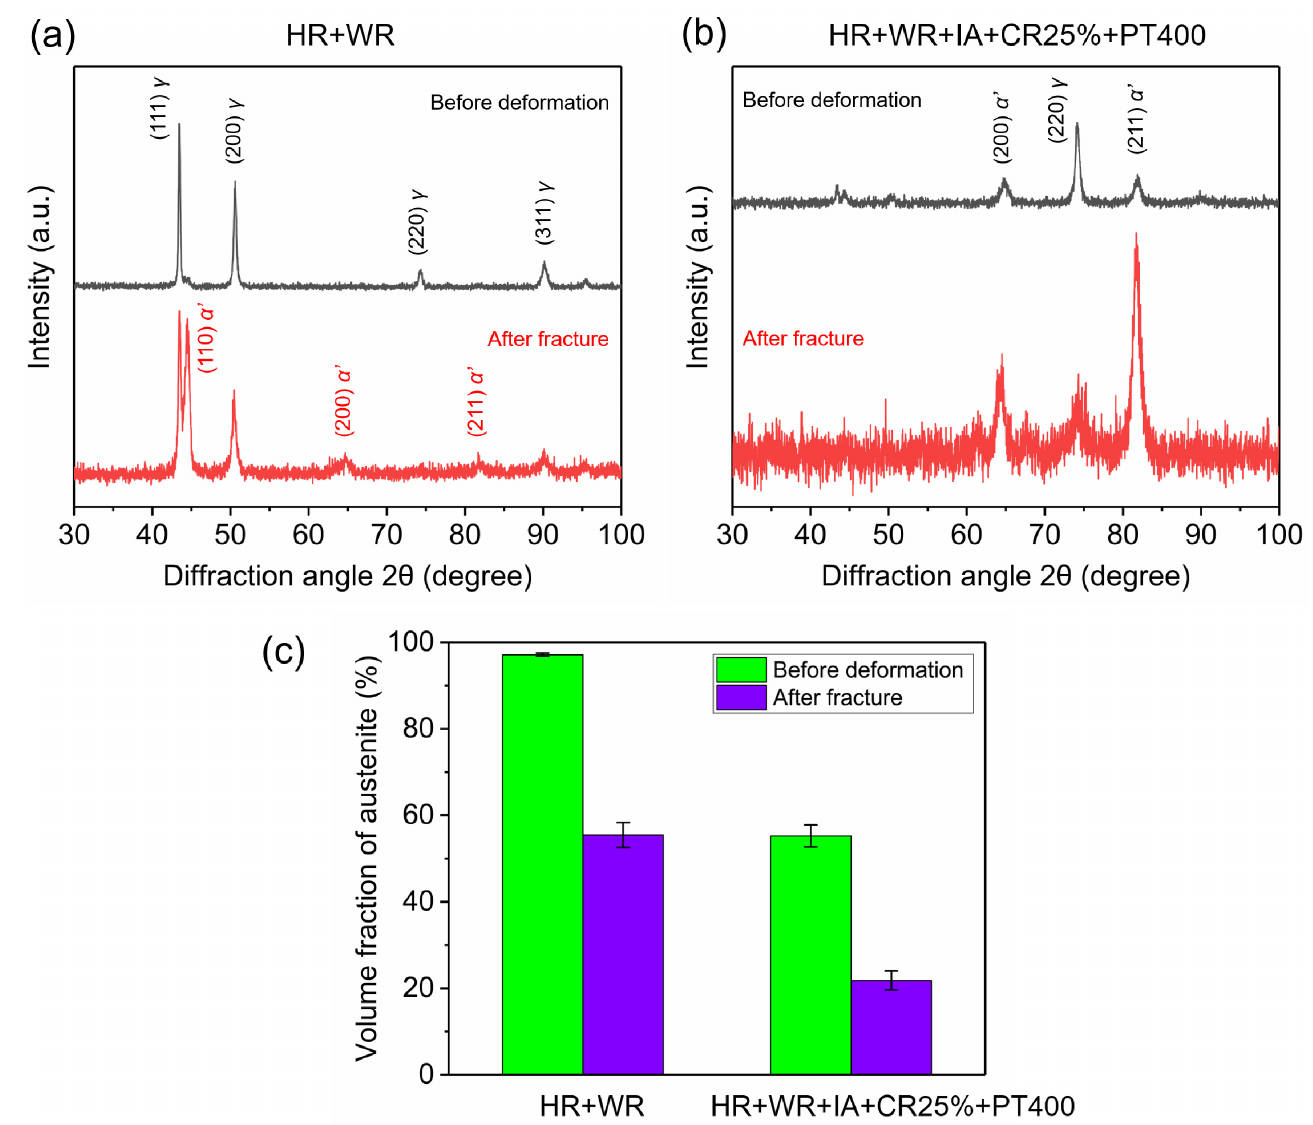
Figure 5. ( a ) XRD profiles of the HR + WR sample before deformation and after fracture, normalized to (111) γ . ( b ) XRD profiles of the HR + WR + IA + CR25% + PT400 sample before deformation and after fracture, normalized to (220) γ . ( c ) Volume fraction of austenite of HR + WR sample and HR + WR + IA + CR25% + PT400 sample before deformation and after fracture.